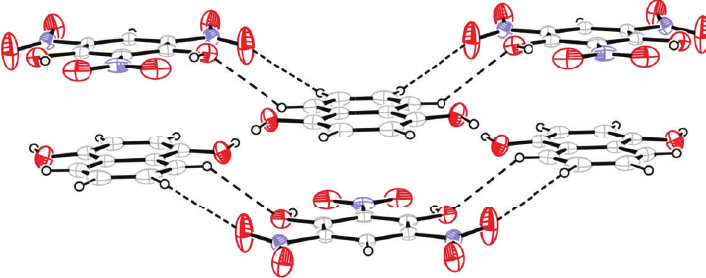
Figure 6: The view of infinite polymeric chains along the 𝑏 axis.